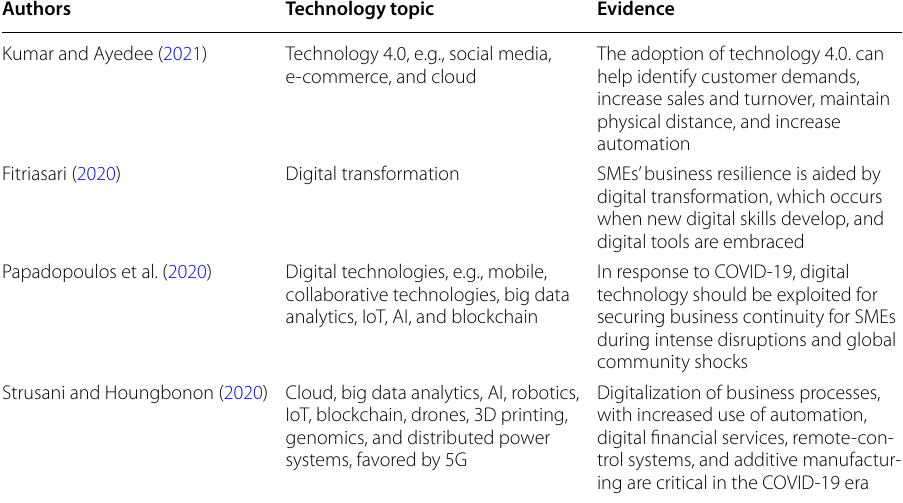
Table 2 Evidence in support of SMEs’ IT adoption during COVID-19